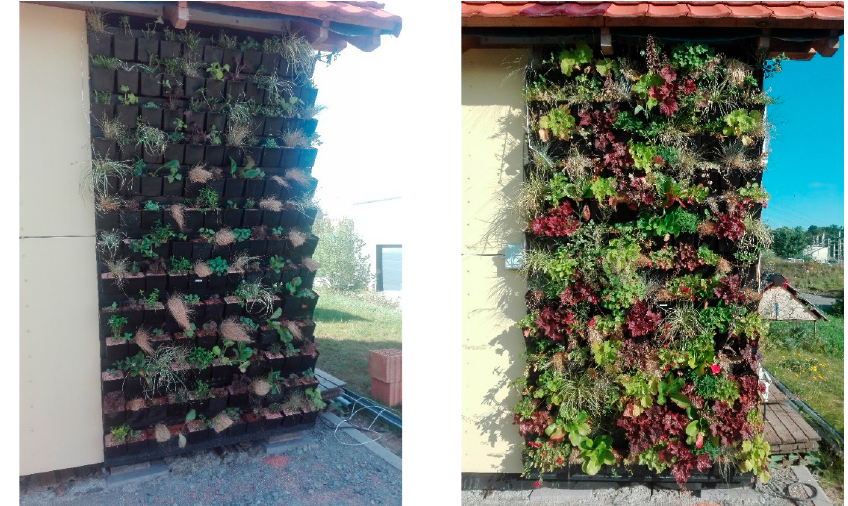
Figure 2. Green wall after establishment and during vegetation.